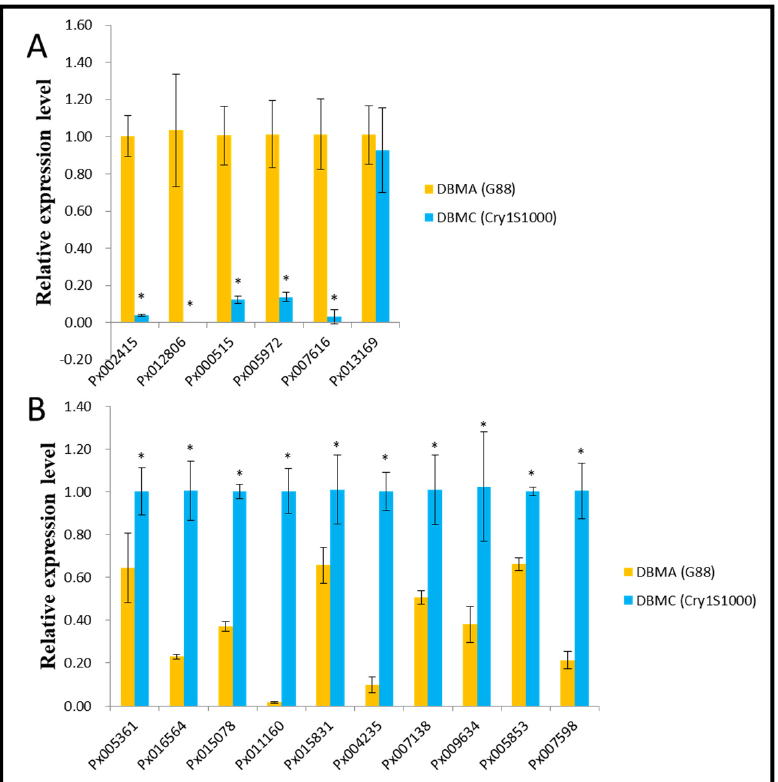
Figure 7. qRT-PCR analysis of differentially expressed genes to confirm the expression patterns indicated by sequencing. ( A ): 6 down-regulated DEGs, ( B ): 10 up-regulated DEGs. Data are shown as mean ± standard deviation (SD) and asterisk indicates significant difference ( p < 0.05).